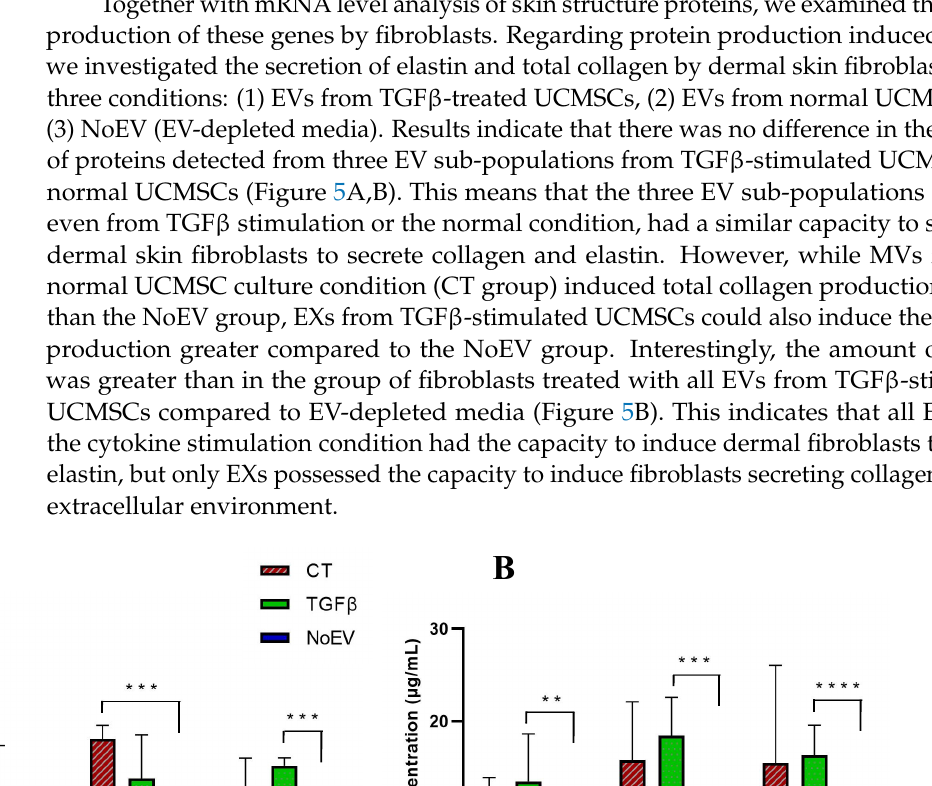
Figure 5. Collagen and elastin secretion by fibroblasts under stimulation of EVs from TGF β -stimulated UCMSCs and normal UCMSCs. ( A ) Total collagen measured by ELISA assay indicated that MVs from the normal UCMSCs and EXs from TGF β -stimulated UCMSCs stimulated collagen secretion by fibroblasts. ( B ) Elastin amount measured by ELISA assay indicated that all ABs, MVs, and EXs from TGF β -stimulated UCMSCs stimulated fibroblasts to release elastin during 2D culture. CT: control group (UCMSCs cultured in normal condition), TGF β : TGF β -stimulated UCMSC group, NoEV: EV-depleted cell culture media, AB: apoptotic body, MV: microvesicle, EX: exosome. N = 3, ** indicates p < 0.01, *** indicates p < 0.001, **** indicates p < 0.0001.